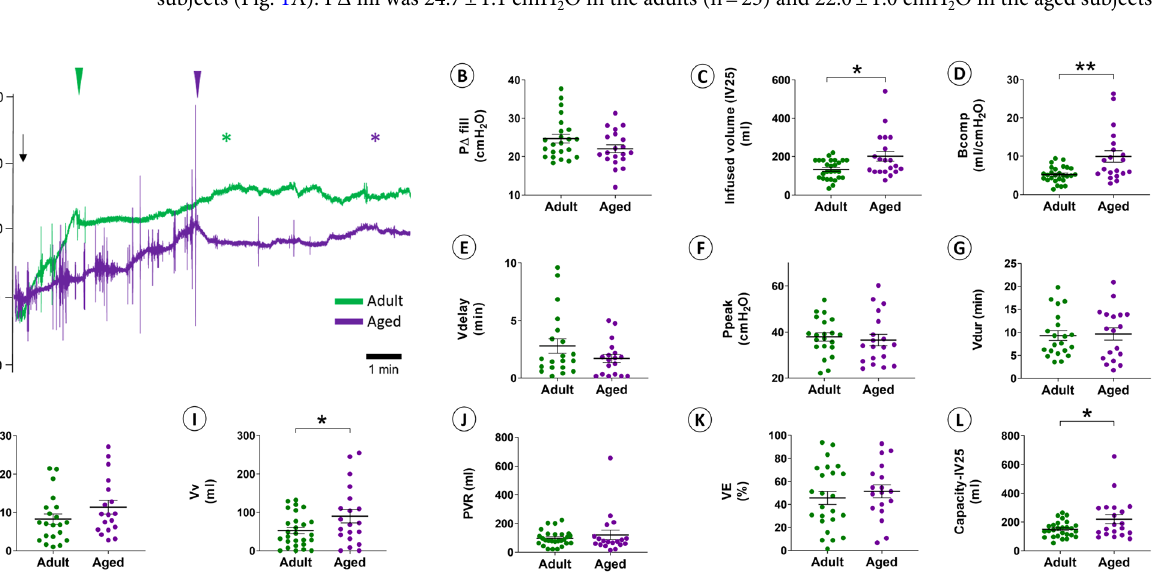
Figure 1. Urodynamic studies in adult and aged rhesus macaques. Reflex micturition was evoked in female subjects and shown by filling cystometry and pressure flow studies ( A ). Following emptying of the bladder, saline was infused to raise bladder pressure about 25 cm H 2 O above baseline (P∆ fill). The black arrow indicates start of bladder infusion, and the green and purple arrow heads indicate end of infusion in representative adult and aged subjects, respectively. Green and purple asterisks show onset of voiding in each of the two subjects. Transient pressure spikes reflect movement artifacts during bladder infusion. Note similar pattern of delayed onset of evoked voiding after partial bladder filling to similar pressures in both subjects. A total of 110 ml was infused in the adult subject, and 240 ml was infused in the aged animal to reach the target bladder pressure elevation. Statistical analysis showed significant elevation of IV25 ( p < 0.05), Bcomp ( p < 0.01), Vv ( p < 0.01), and Capacity-IV25 ( p < 0.01) ( C , D , I , L ) in the aged cohort compared to adult animals, whereas there was no detectable difference in P∆ fill, Vdelay, Ppeak, Vdur, Vflow, PVR, or VE between the groups ( B , E , F , G , H , J , K ). Data are presented as mean ± SE, and statistics are shown as * indicating p < 0.05 and ** indicating p < 0.01 between